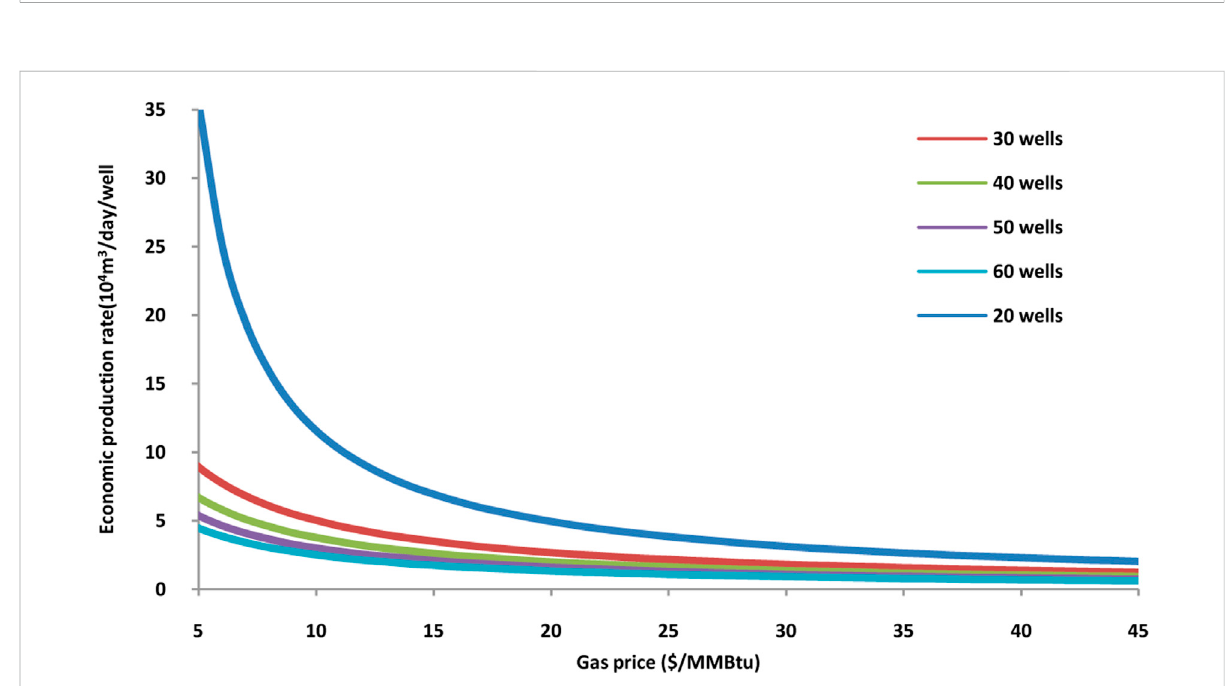
FIGURE 5 Sensitivity analysis of the gas price on economic production rate with the different number of wells with the gas – water ratio set at